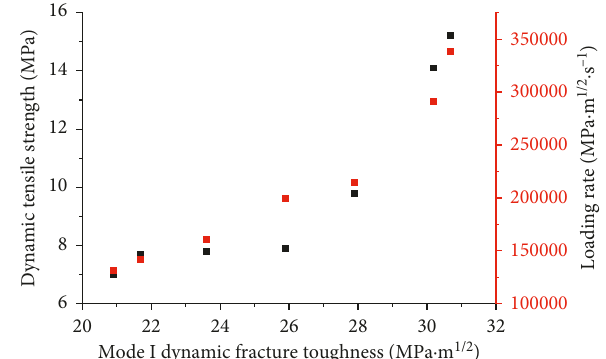
Figure 8: Relation between dynamic fracture toughness and dynamic tensile strength of 610m.